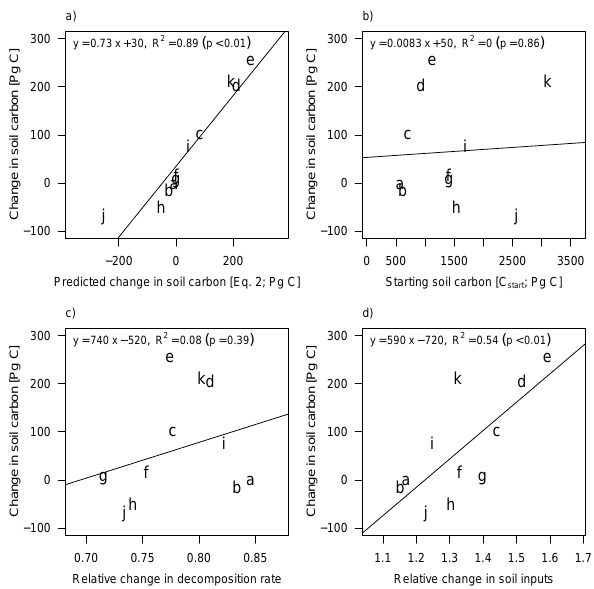
Fig. 7. Change in decomposition rate between 1997–2006 and Fig. 6. Change in global soil organic carbon between 1997–2006 2009–2099 global means due to variation in (a) starting decom- and 2090–2099 global means as a function of (a) Eq. (2), the rel- position rate, Q 10 , and soil temperature change from Eq. (7), ative change in input and decomposition rate times the initial soil (cid:17) (cid:16) 1T (cid:18) 1 + 1I (cid:19) k start ln (Q 10 ) , (b) starting decomposition rate, k start , (c) tem- 10 I start − 1 × C start , (b) starting soil carbon stock, carbon stock, perature dependency, Q 10 , and (d) change in soil temperature, 1 + 1k k start 1T . The models are represented as follows; a: CESM1(BGC), b: C start , (c) the inverse of the relative change in decomposition rate NorESM1-ME, c: BNU-ESM, d: BCC-CSM1.1(m), e: HadGEM2- ( k ), 1 , and (d) relative change in soil inputs ( I ), 1 + 1I . The I start 1 + 1k k ES, f: IPSL-CM5A-MR, g: GFDL-ESM2G, h: CanESM2, i: INM- start models are represented as follows; a: CESM1(BGC), b: NorESM1- CM4, j: MIROC-ESM, and k: ME, c: BNU-ESM, d: BCC-CSM1.1(m), e: HadGEM2-ES, f: IPSL- CM5A-MR, g: GFDL-ESM2G, h: CanESM2, i: INM-CM4, j: MIROC-ESM, and k: MPI-ESM-MR.